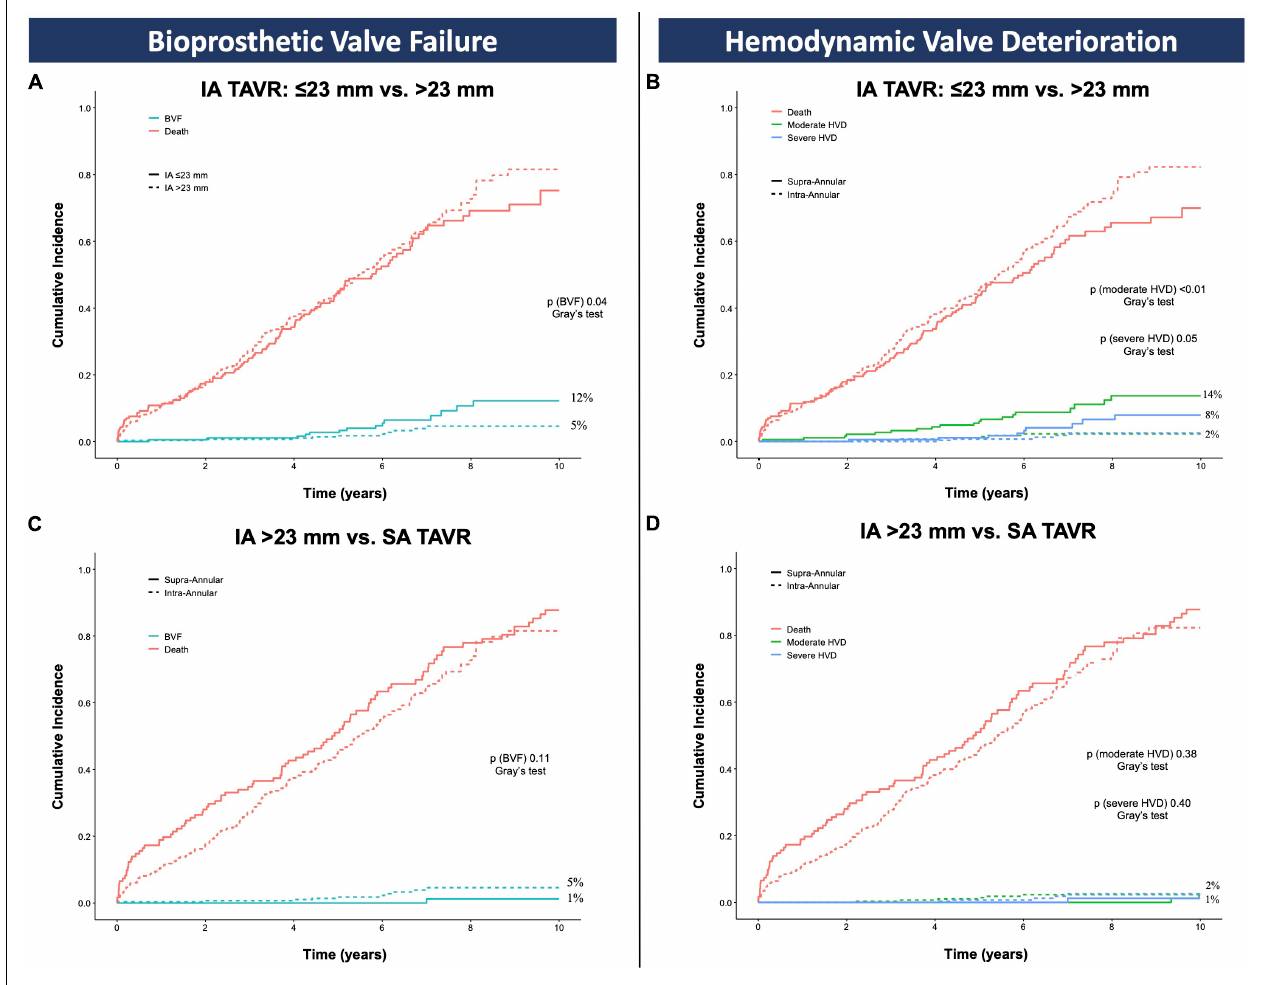
FIGURE 4 | Cumulative incidence function of bioprosthetic valve failure (A,C) and hemodynamic valve deterioration (B,D) accounting for death as competing risk; p values are obtained with the Gray’s test and refer to the comparison between IA ≤ 23 mm vs. IA > 23 mm (A,B) and IA > 23 mm vs. SA group (C,D) . BVF, bioprosthetic valve failure; HVD, hemodynamic valve deterioration; IA, intra-annular; SA, supra-annular; TAVR, transcatheter aortic valve